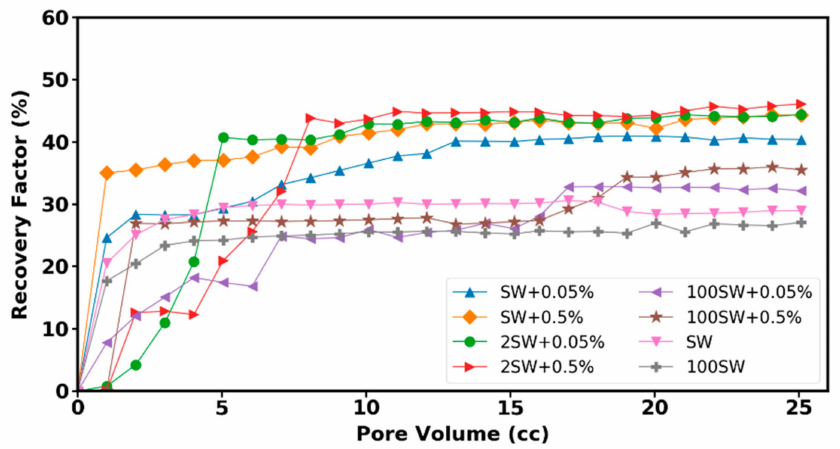
Figure 14. Oil recovery factor as a function of injection time for six displacing fluid for oil-wet porous